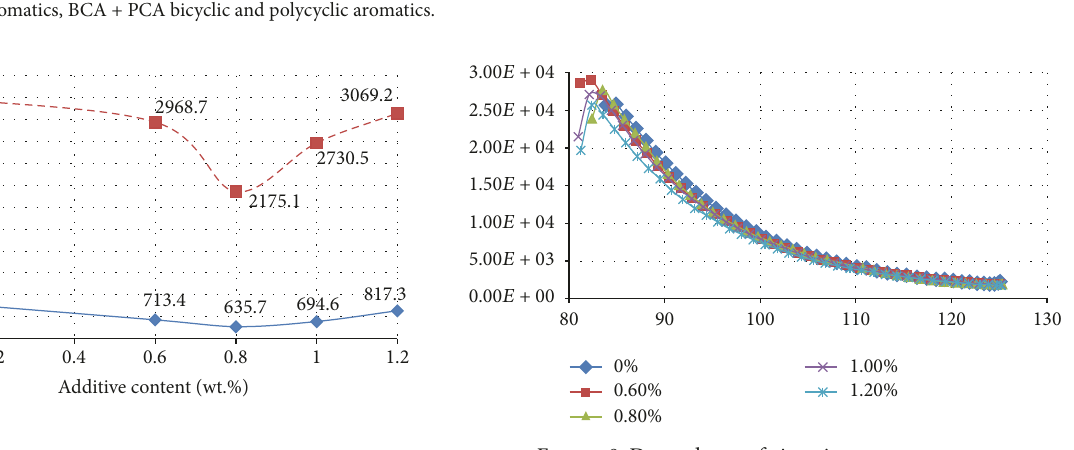
Figure 8: Dependence of viscosity on